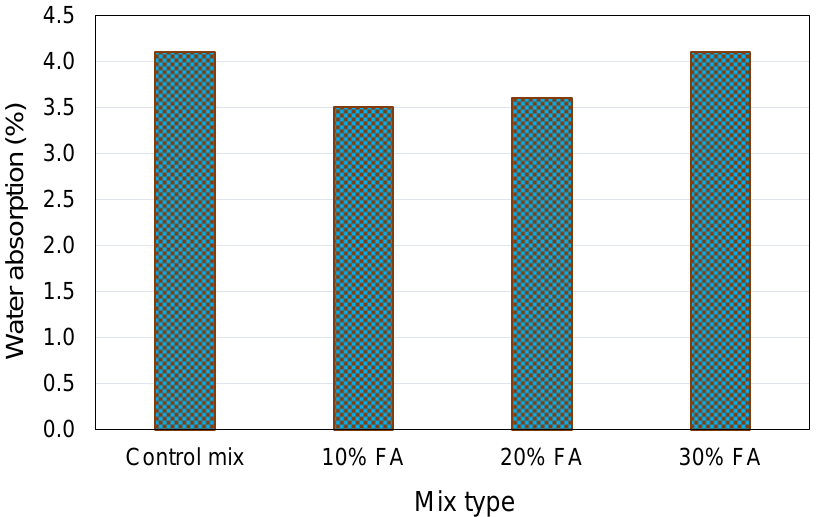
Figure 6. Water absorption of concrete at various contents of fly ash [145].